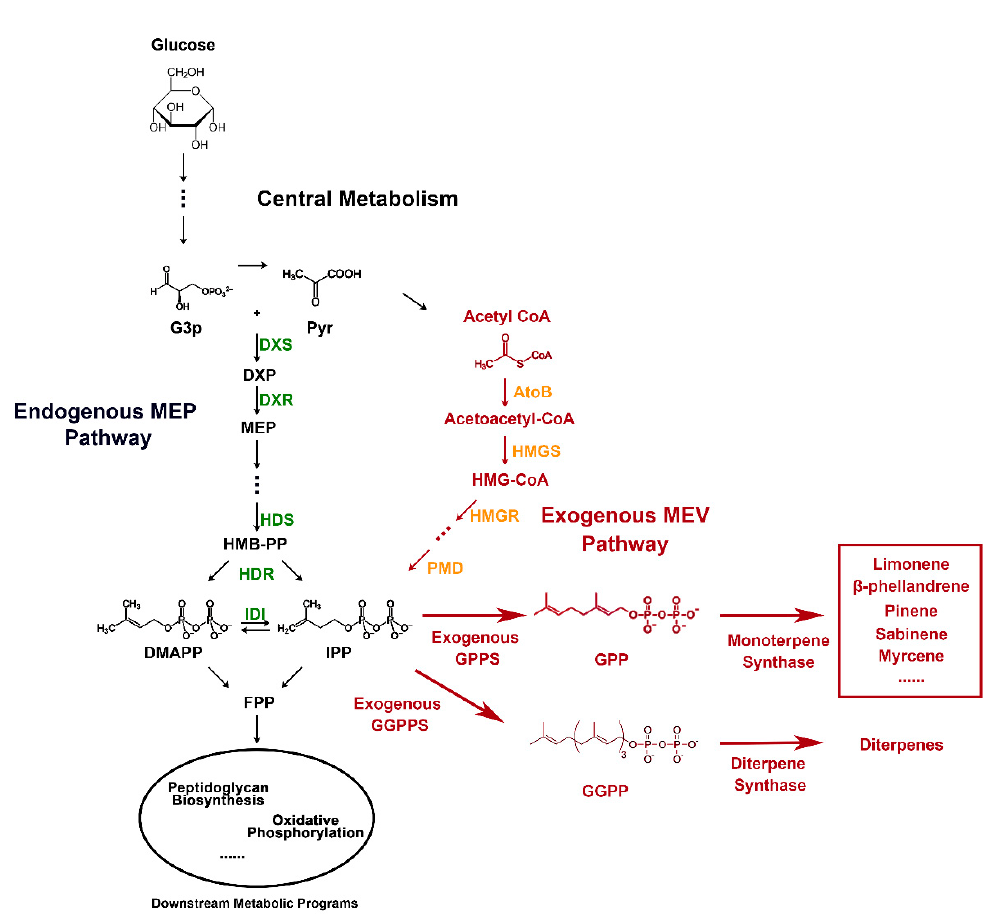
Figure 1. Monoterpene synthesis pathway in engineered prokaryotic host. GA3P, D-glyceraldehyde 3-phosphate; CoA, coenzyme A; MEP, methylerythritol 4-phosphate; DXS, 1-